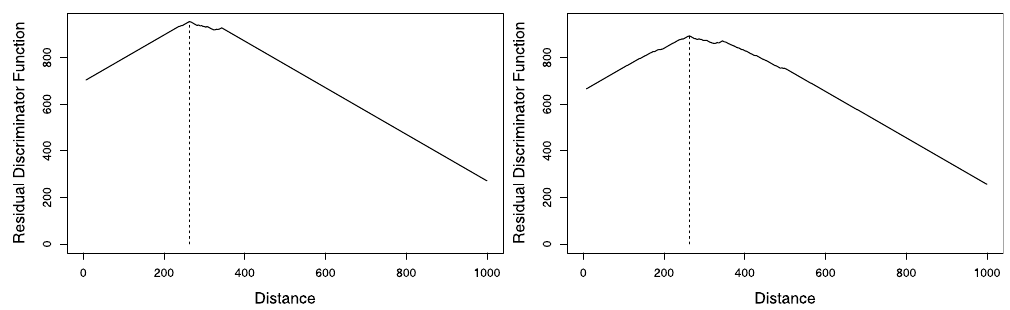
Figure 2. Residual discriminator function ( R ) for global DNRC distributions, relatively to the complete human genome, for k = 6 (left) and k = 7 (right). Both reach their maximum at distance 262.